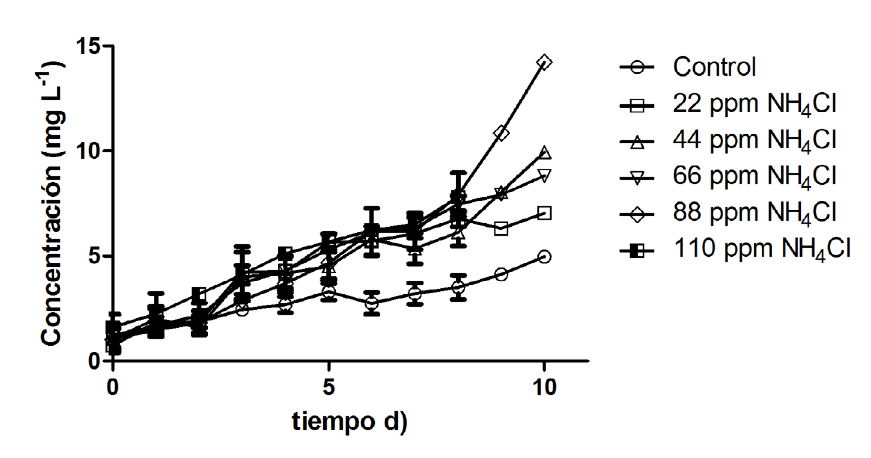
Figure 4: Chlorophyll concentration at different NH